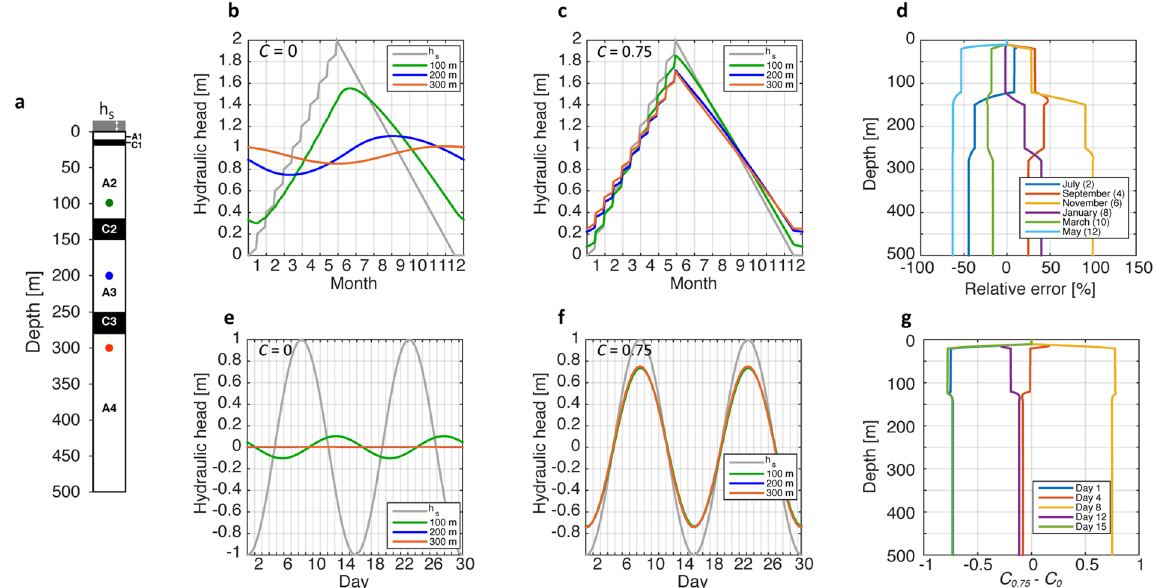
Figure 5. Model simulations showing the influences of poroelasticity. ( a ) Model configuration of permeable (A1-4) and confining (C1-3) units, with parameter values (A1-4) K = 10 − 5 m/s, S s = 10 − 5 m − 1 ; (C1-3) K = 10 − 8 m/s, S s = 10 − 4 m − 1 . A column of fresh water at the surface ( h s ) represents surface water depth. Colour- coded dots at depths 100 m (green), 200 m (blue) and 300 m (red) show where hydraulic head is reported for a monsoonal ( b and c ) and a tidal ( e and f ) scenario for different values of C . A value for C = 0.75 was chosen as representative for the BAS, as described in the text. In ( d ) the relative difference between the monsoonal scenario simulations with C = 0 and C = 0.75 is expressed as relative error calculated as − . C C absolute difference between the tidal scenario simulations with C = 0 and C = 0.75 is illustrated.